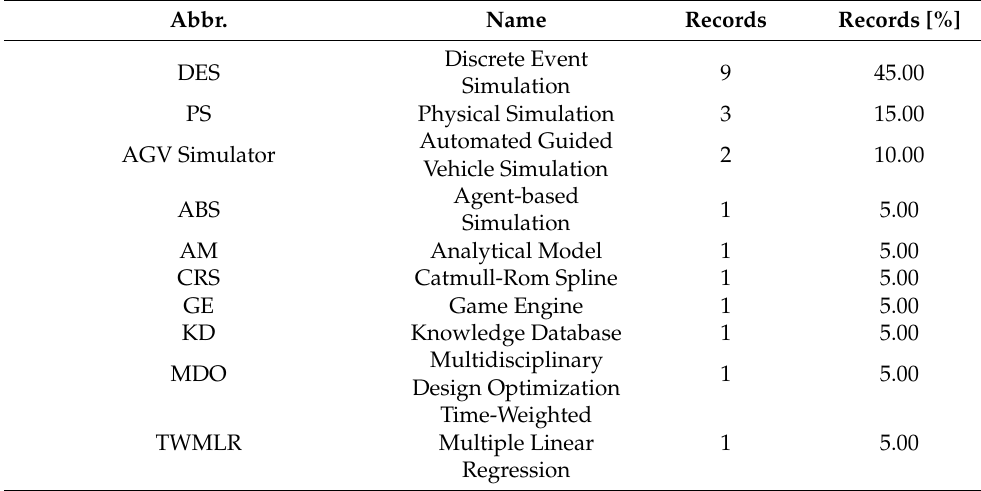
Table 10. Virtual Models for Digital